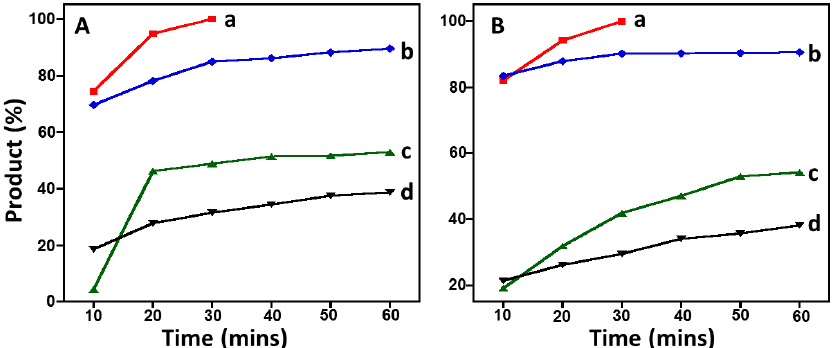
Figure 7. Time dependent conversion efficiency of the Suzuki reaction employing ( A ) PG ‐ HRG ‐ Pd ‐ 1 and ( B ) PG ‐ HRG ‐ Pd ‐ 2 for various substrates (a) iodobenzene, (b) bromobenzene, (c) chlorobenzene, and (d) chloro benzophenone with phenylboronic acid under aqueous and aerobic conditions determined by GC analysis.